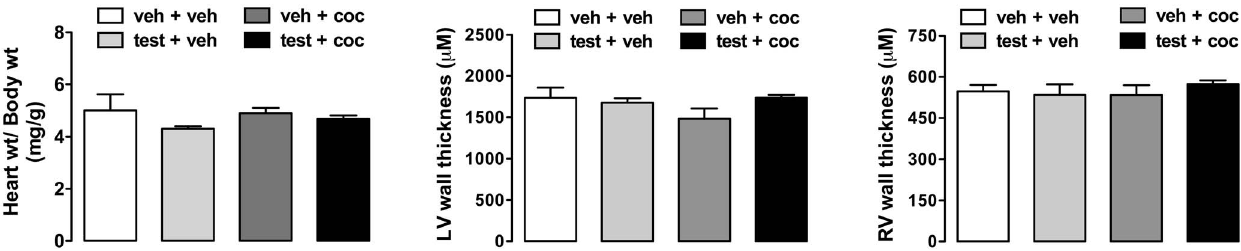
Figure 4. Relative weight of heart (heart weight/body weight) and left and right ventricular wall thickness in adolescent animals subjected to treatment for 10 consecutive days with testosterone and cocaine alone and in combination. The bars represent the mean 6 SEM. veh – vehicle, test - testosterone and coc - cocaine. One-way ANOVA followed by Bonferroni’s post hoc test.